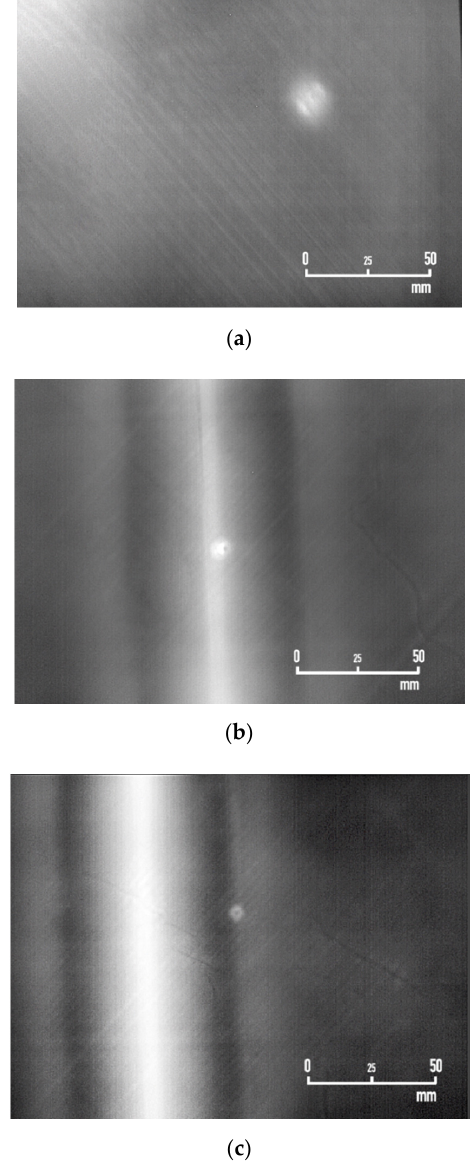
Figure 12. Infrared thermograms of impact damages on the industrial-scale composite panel collected by the PPI-LT strategy and module. D1 is depicted in ( a ), D2 in ( b ), and D3 in ( c ).